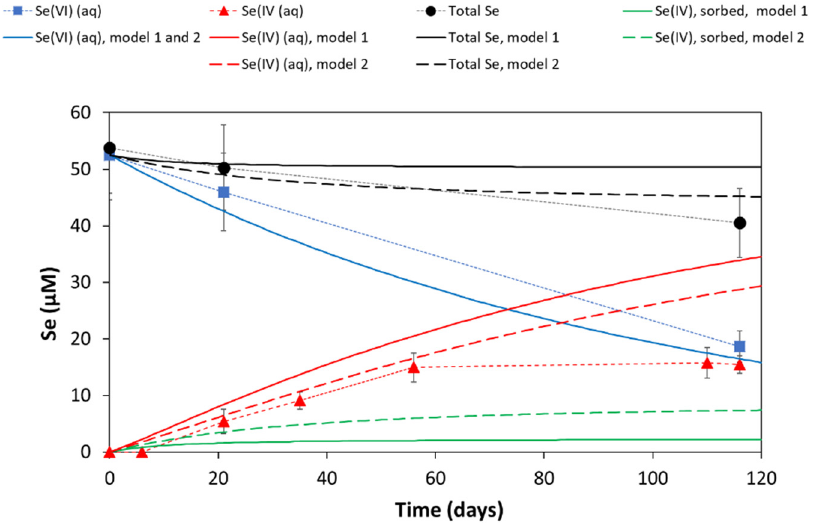
Figure 7. Measured aqueous Se(VI) (blue squares), Se(IV) (red triangles), and total aqueous Se (black circles) concentrations in batch experiment Bio_Se(VI)-CF-a (more details in Table 2), compared to two PHREEQC models representing first order reduction of Se(VI) and sorption of Se(IV). Model 1 (full lines) includes the 2-site Langmuir isotherm of Frasca et al. [18], while in model 2 (dashed lines) the isotherm has been adjusted to represent the Rd values for Se(IV) sorption obtained from the abiotic batch experiments. The two green curves represent the sorbed concentration of Se(IV) according to Equation